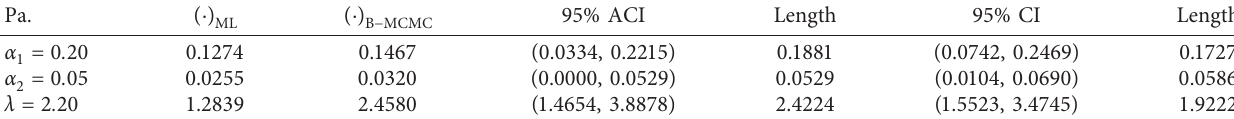
Table 3: Point and 95% interval ML and Bayes estimate.